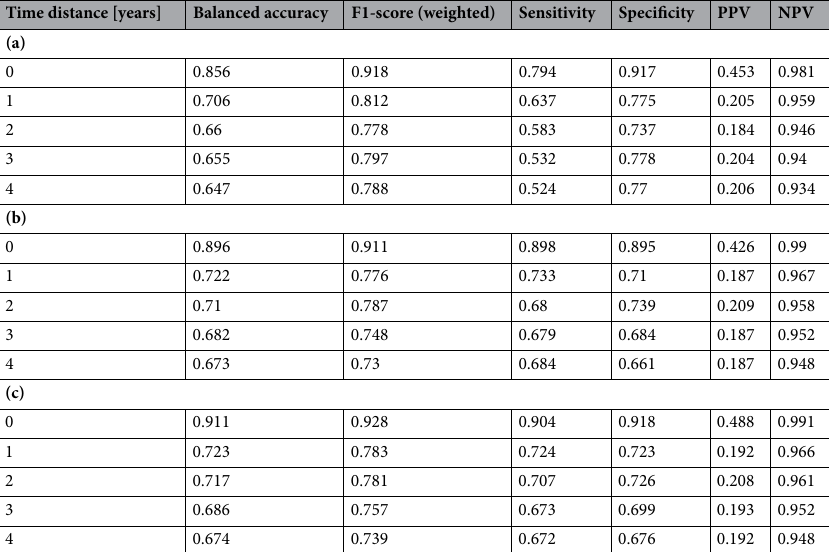
Table 3. Metrics for predicting death using logistic regression (a), random forests (b) and extreme gradient boosting (c). Models built on a follow-up period of 1 year and time distances (from 0 to 4 years).